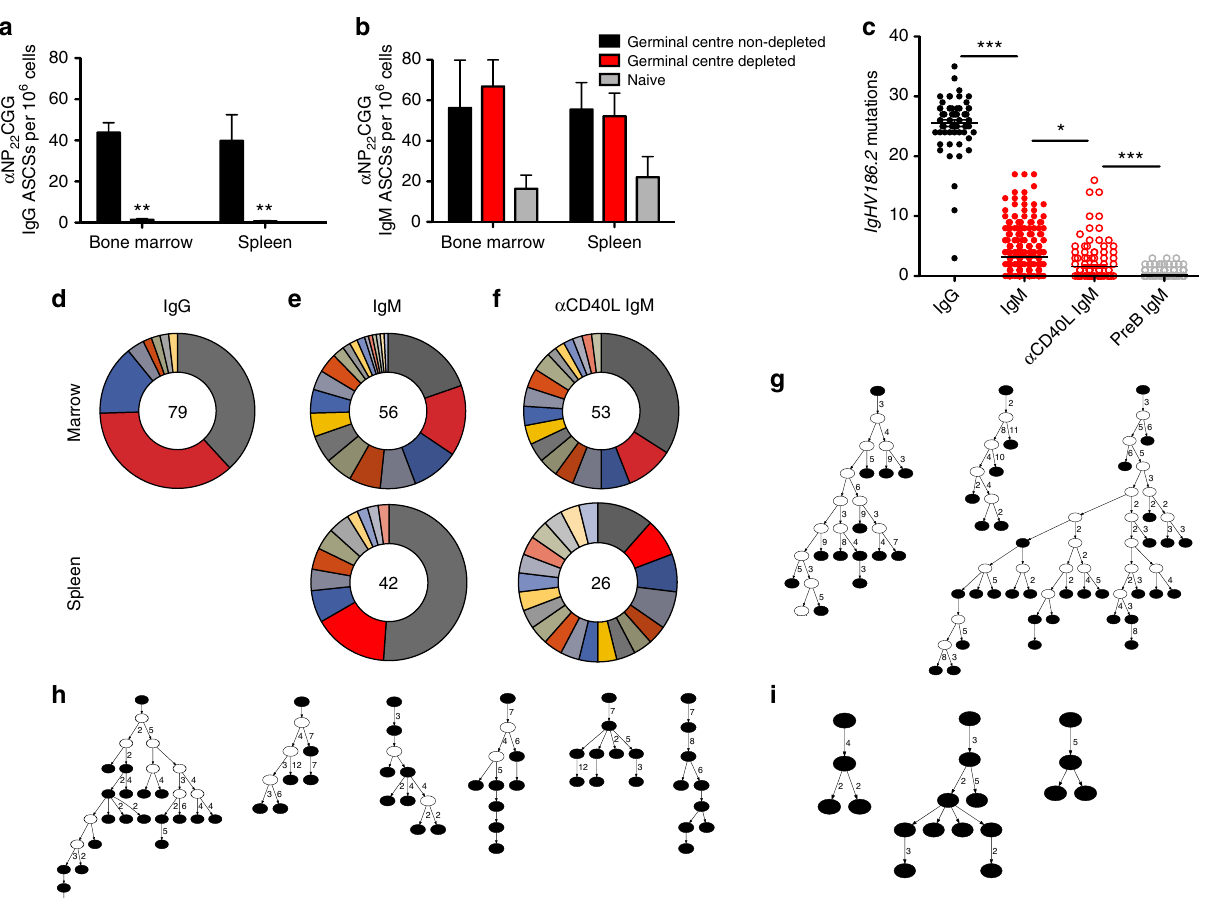
Figure 3 | IgM PCs show evidence of SHM even when GCs are ablated. ( a , b ) NPCGG-specific IgG (filled black square) and IgM (filled red square) ASCs in mouse cohorts treated with either control IgG ( n ¼ 5), a CD40L antibody to deplete GCs ( n ¼ 7), or in age-matched naive controls (filled red square, n ¼ 3), as measured via ELISPOTat day 45 post immunization. The mean ( ± s.e.m.) is shown with ** indicating P o 0.005. ( c ) IgG (black circles) and IgM IgHV186.2 sequence mutations in cohorts of C57/BL/6 mice at 1 and 3 months post-NP 22 CGG immunization (pooled), with (red open circles) or without (red circles) a CD40L treatment, compared with total heavy chain sequences from pre-B-cell unmutated controls (open grey circles) isolated from immunized C57/BL/6 cohorts ( n ¼ 4). Spleen and bone marrow PCs are pooled; Student’s t -test * P o 0.05 and *** P o 0.001. Refer to Supplementary Table 1 for sequence numbers. ( d ) Representative clonality of C57/BL/6 bone marrow IgG PCs post immunization—each section represents a shared CDR3 junction as a percentage of total sequences as listed in the centre. Representative clonality of C57/BL/6 IgM PCs in the spleen and bone marrow, treated with control Ig ( e ) or with a CD40L ( f ). Ig lineage trees for IgG ( g ) and IgM PCs, treated with with control Ig ( h ) or with a CD40L ( i ). Filled nodes represent germline or sample sequences; empty nodes indicate inferred precursors. Each line denotes either a single mutation between parent and daughter if no number is